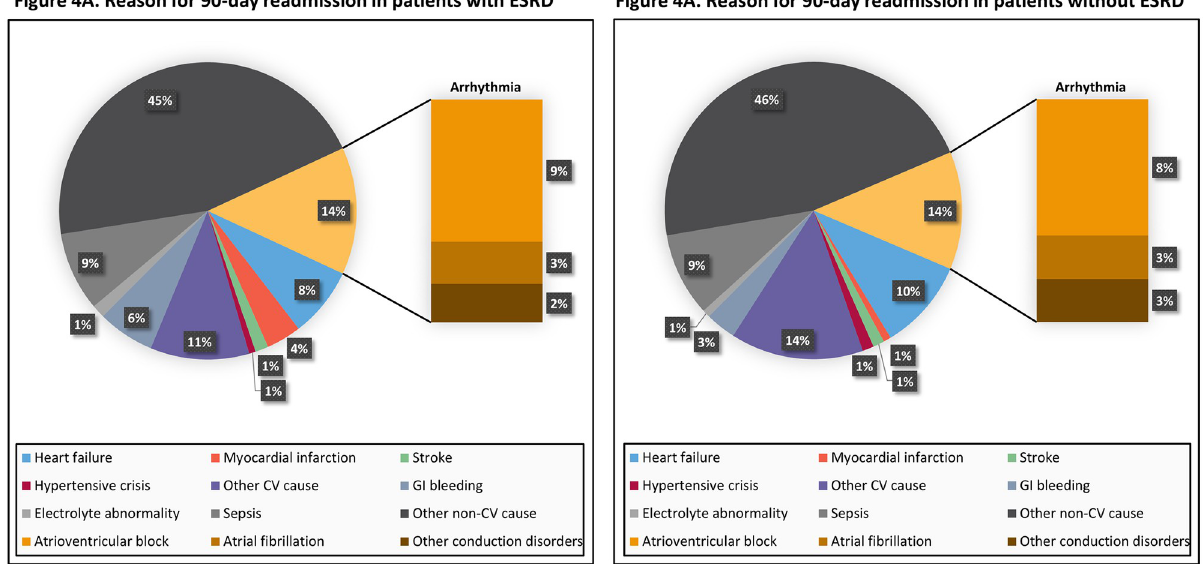
Fig 4. Reasons for post-TAVR readmissions in patients with and without ESRD. The pie graph on the left (Fig 4A) illustrates the percentage of different causes of 90-day readmissions in patients with ESRD. Each cause is color-coded according to the legend below the pie graph. Arrhythmia has been further divided into atrioventricular block, atrial fibrillation, and other conduction disorders. The same applies for the pie graph on the right (Fig 4B), but in patients without ESRD. Abbreviations: CV = cardiovascular; GI = gastrointestinal.